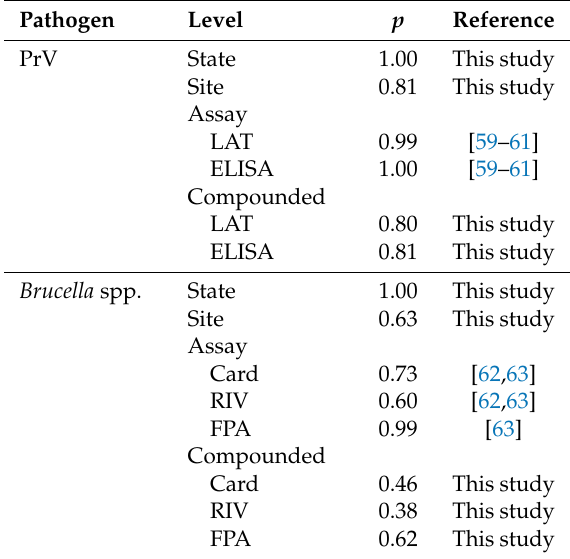
Table 1. Hierarchical uncertainty for the detection probability ( p ) of pseudorabies virus (PrV) and Brucella spp. antibodies in wild pig populations of Florida, U.S. (2007–2014). LAT = latex agglutination test; ELISA = enzyme-linked immunosorbent assay; card = acidified antigen test; RIV = rivanol test; FPA = fluorescence polarization